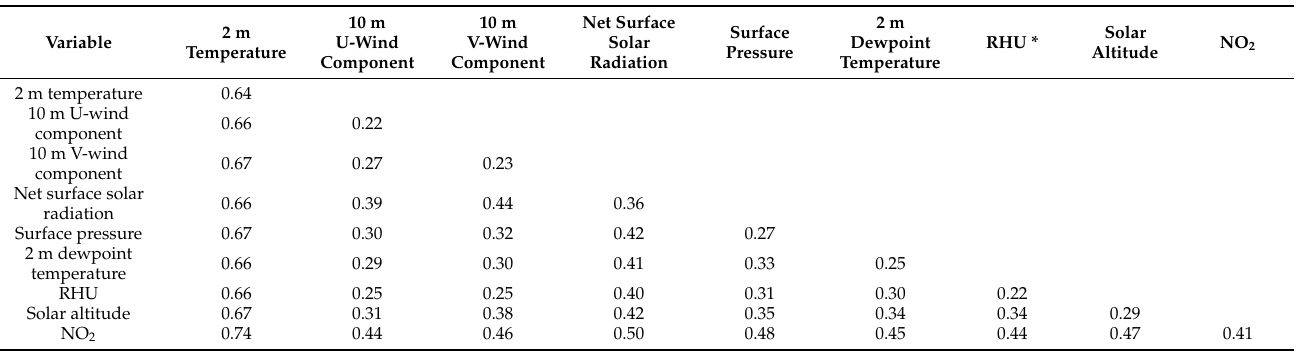
Table 2. Impact factor interaction detection to ozone